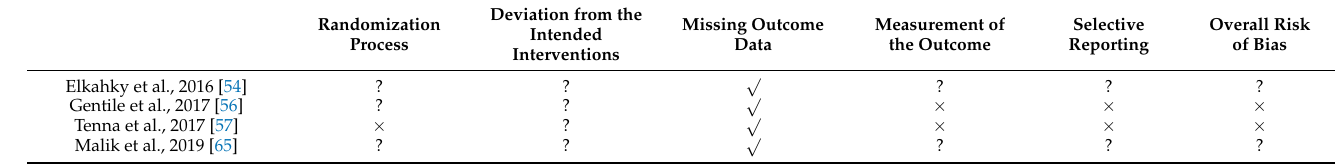
Table 3. Risk of bias assessment in randomized controlled